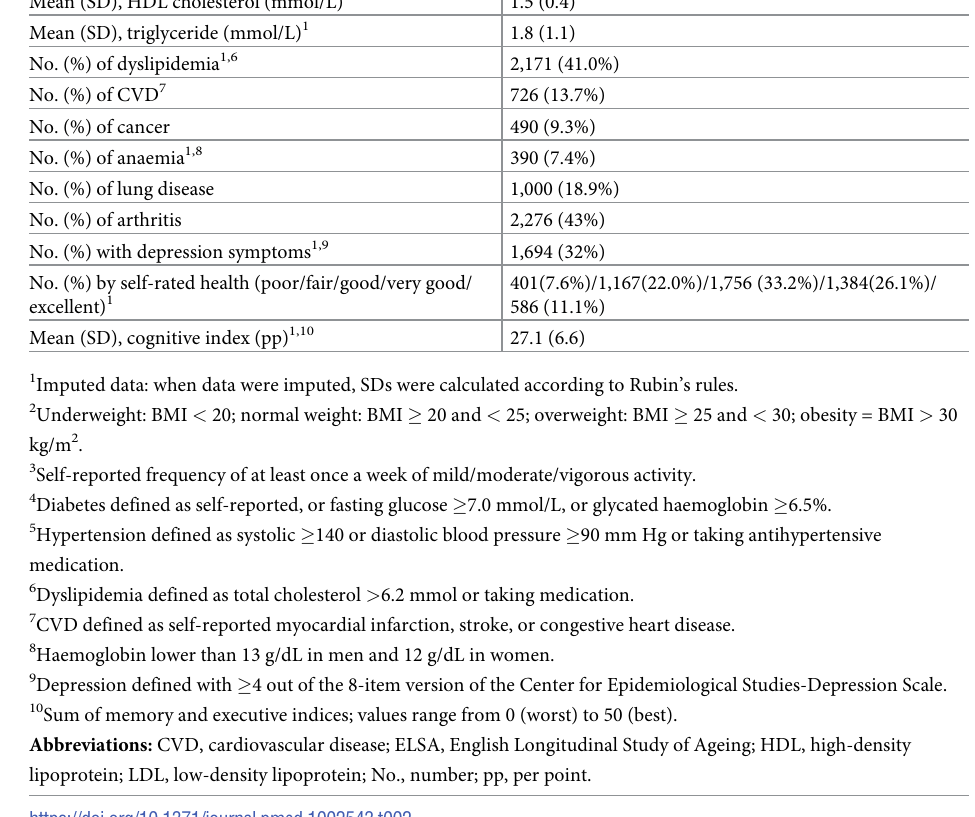
Fig 1B and Table 3 illustrate the same analysis using categorical variables (frailty status). In sex-adjusted models, HRs ranged from 1.2 (95% CI: 0.9–1.7) to 3.4 (95% CI: 1.4–8.0), with 30 out of 37 cases showing a statistically significant association. Adjustments in model 2 attenu- ated associations, while retaining statistical significance in 28 out of 37 cases. HRs for model 2 ranged from 1.2 (95% CI: 1.0–1.4) to 3.0 (95% CI: 1.5–6.2). Adjustments in model 3 attenuated associations for all scores, retaining statistical significance in 10 out of 37 cases. HRs for model